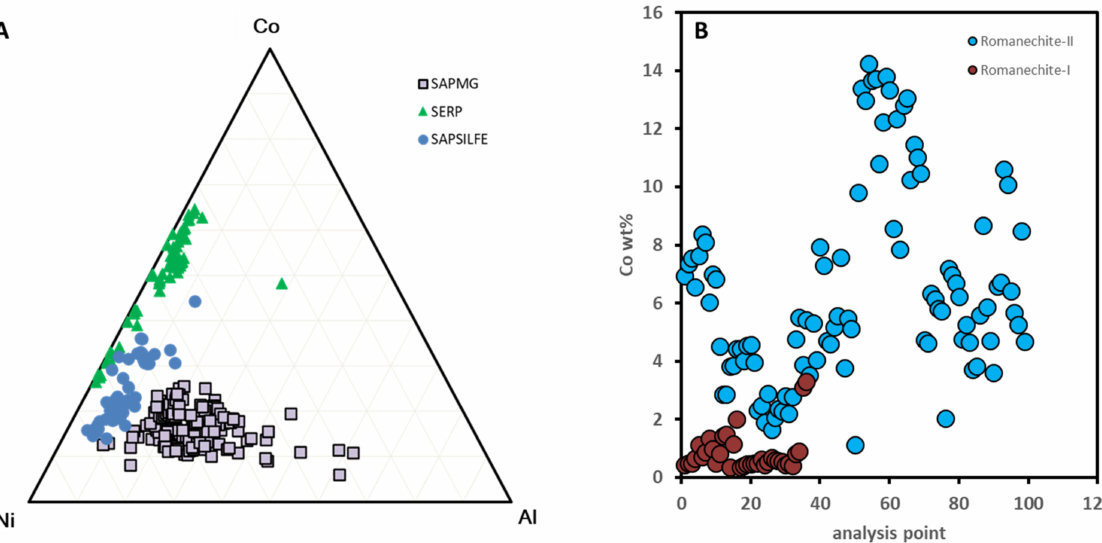
Figure 11. ( A ) Relative contents of Al, Ni and Co (wt%) measured by EMPA in Mn oxy-hydroxide grains from three units of the Piau í profile, and ( B ) the Co content (wt%) in the romanechite Mn oxy-hydroxide grains separated by Ba concentration. The Ba content cut-off between romanechite-I and romanechite-II was 2